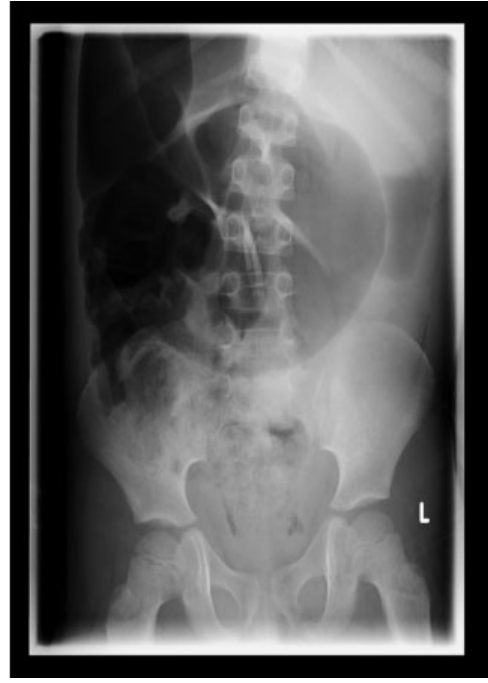
Fig. 1 Abdominal radiograph showing colonic dilatation, feces in the rectum and no proximal small bowel dilatation.